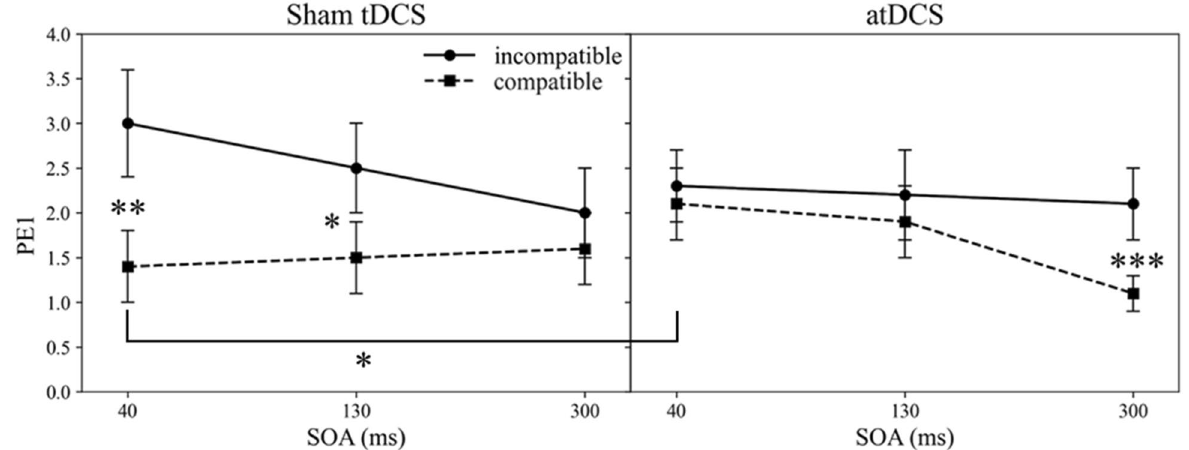
Figure 4. The percentage error in Task 1 (PE1) for compatible and incompatible trials across SOA (in ms), for atDCS and sham tDCS. Error bars represent standard error of the mean. * p ≤ 0.05, ** p ≤ 0.01, *** p ≤